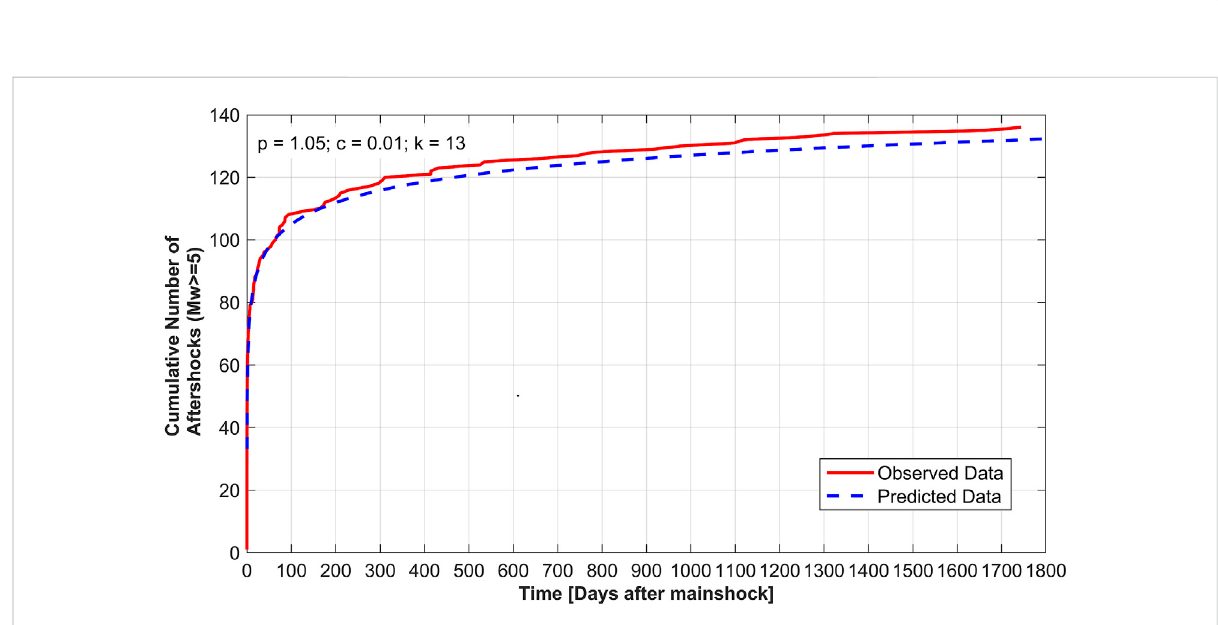
indication that aftershocks of signi fi cant magnitudes may occur (Utsu et al., 1995). We can notice a similar situation for the M ≥ 5 predicted and observed curves in Figure 4. As the p -value,